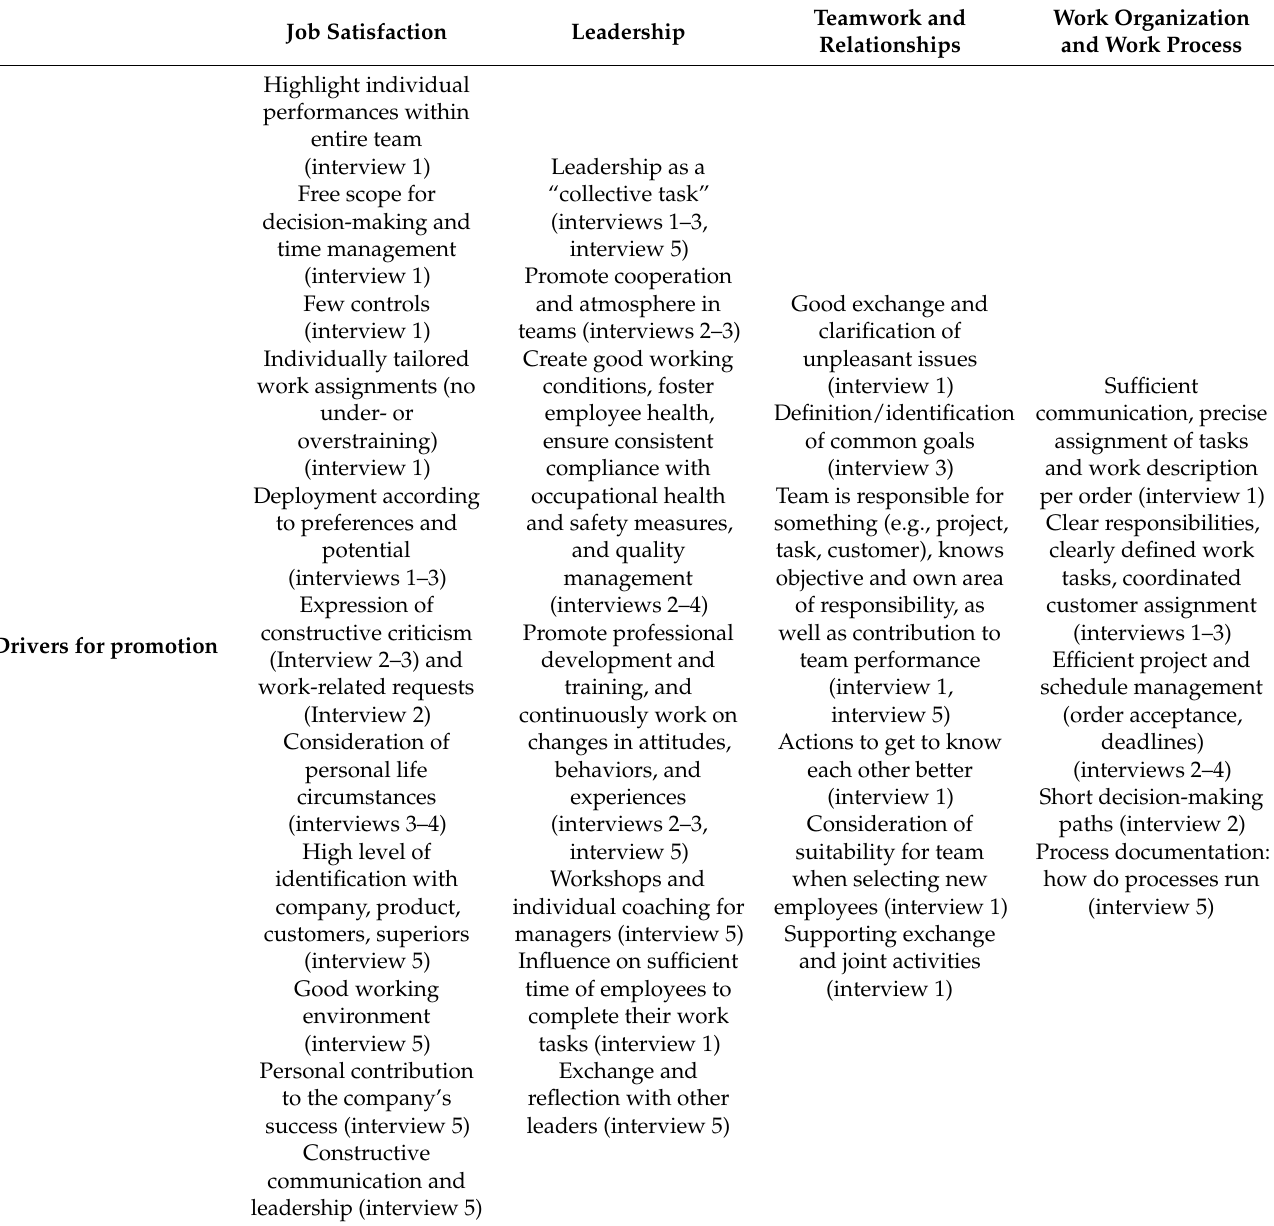
Table 2. Drivers for the promotion of job satisfaction, leadership, teamwork, and relationships, and work organization and work